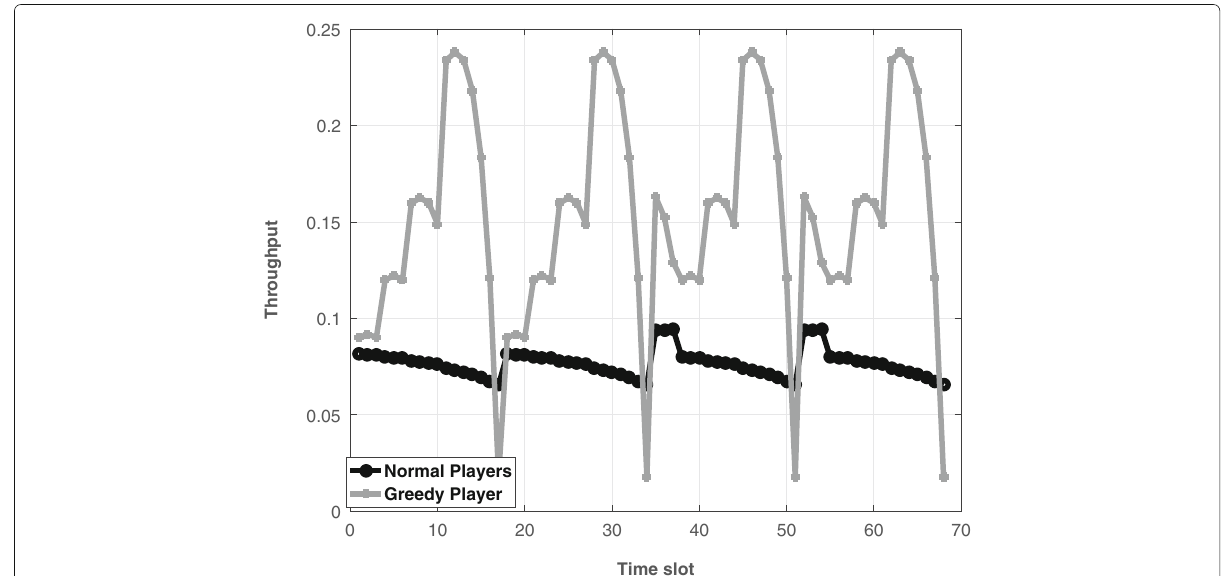
Fig. 3 The cyclic behavior of a moving greedy player’s throughput compared to average throughput of static normal players in an affected cell